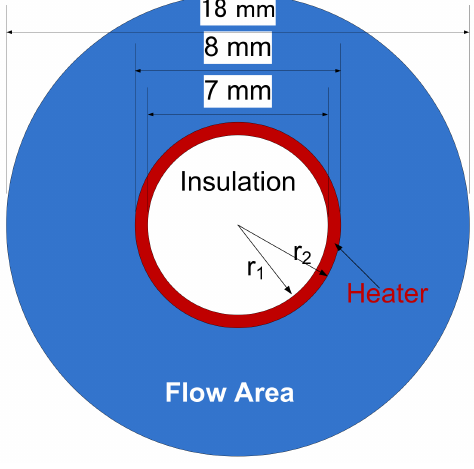
Figure 4. Cross-section view of the heater and flow area in the Hino CHF test [25].